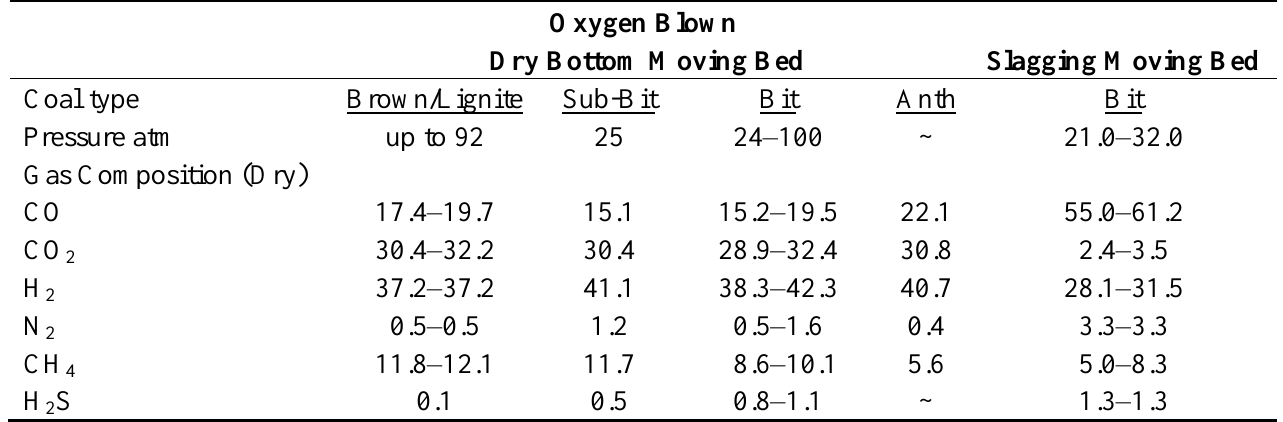
Table 8. Typical gas composition for entrained flow gasifiers